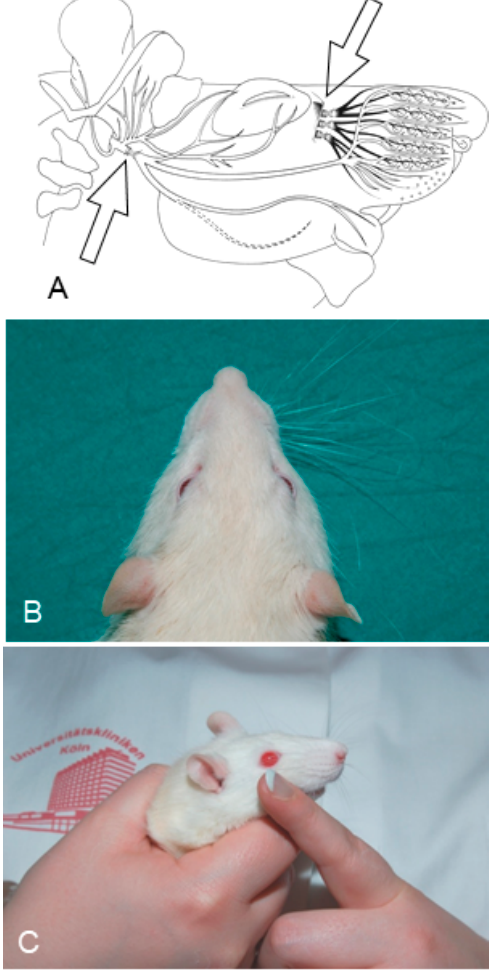
Figure 4. Schematic drawings illustrating transection and end-to-end suture of the infratemporal portion of the right motor facial nerve (Fn-n; ( A ), lower arrow) and the sensory infraorbital branch of the trigeminal nerve, IOn-n (( A ), upper arrow), adopted from (Dörfl 1985; Semba and Egger 1986) [66,76]. ( B , C ) Images of postoperative treatments: ( B ) The vibrissae on the left side of the face were trimmed to maximize vibrissal use on the operated, right side; ( C ) Manual stimulation of the whisker pad skin and musculature on the operated, right, side. ( A – C ): From Bendella et al. (2011) [77]. Four months after the transection and anastomosis of Fn and IOn (Fn-n + IOn-n) without treatment, in the rats in control group 1 recovery was poor; the amplitude and angular velocity during whisking were reduced to about 20% of the value in intact rats (11 ± 4°). All three postoperative stimulation procedures in the experimental groups 2–4 improved function, with significantly higher amplitudes of vibrissal whisking than the control rats in group 1: Fn-n + IOn-n + Vstim 28 ± 9°; Fn-n + IOn-n + Mstim 30 ± 11°; Fn-n + IOn-n + Vstim + Mstim 32 ± 10°. Whilst the amplitudes in all the experimental groups were not significantly different, but significantly better than those in the control group 1, the clear functional improvements in vibrissal whisking amplitude were ~50% less than the values in intact animals.